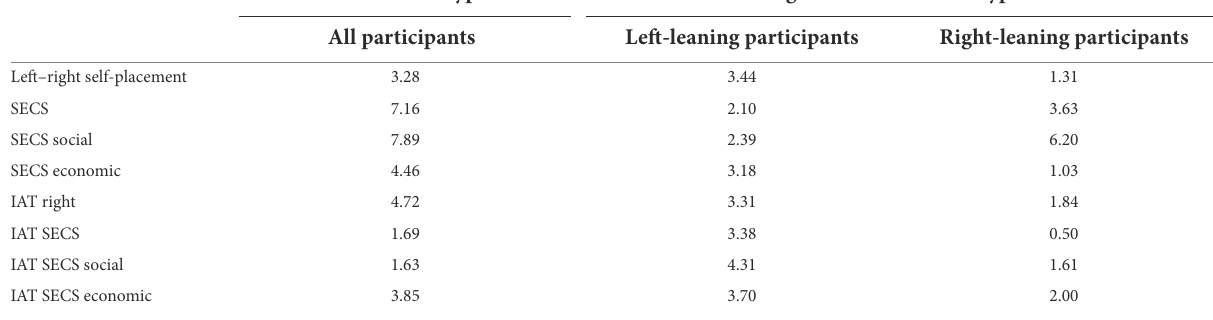
TABLE 2 Bayes factors in the direction of the null hypothesis for each measure and each hypothesis. Conservative shift